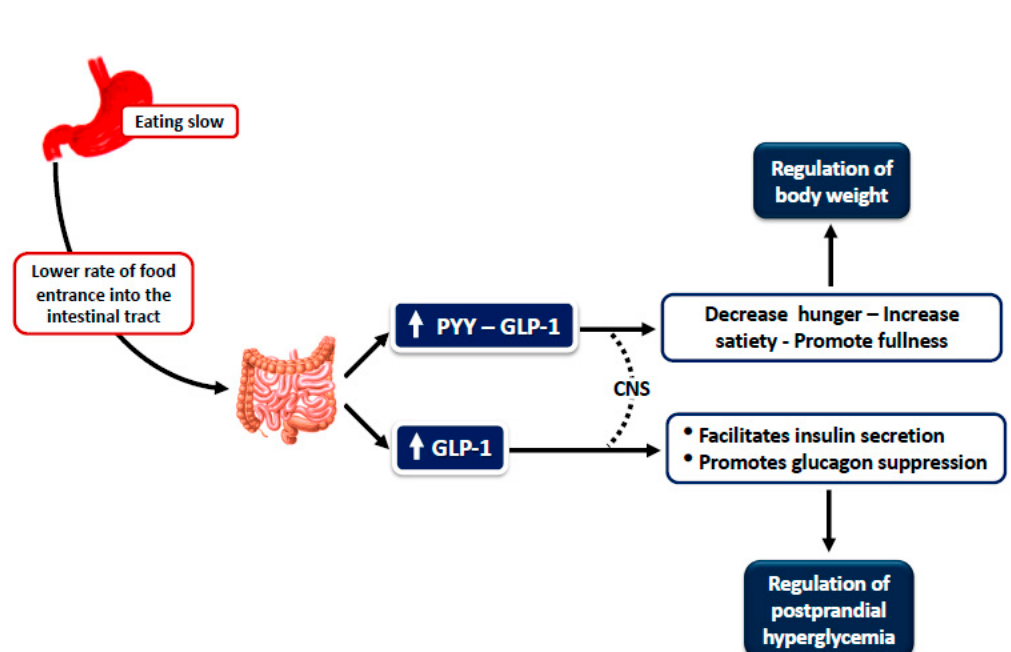
Figure 1. Schematic presentation of gut hormone responses and clinical outcomes in healthy individuals eating at a slow rate [15].